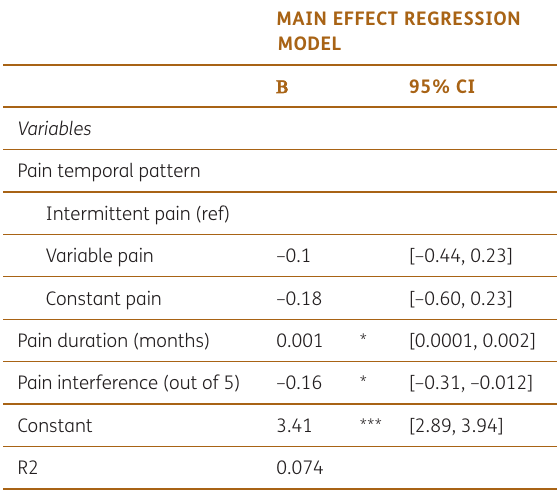
Table 1 The main linear regression predicting FTP.